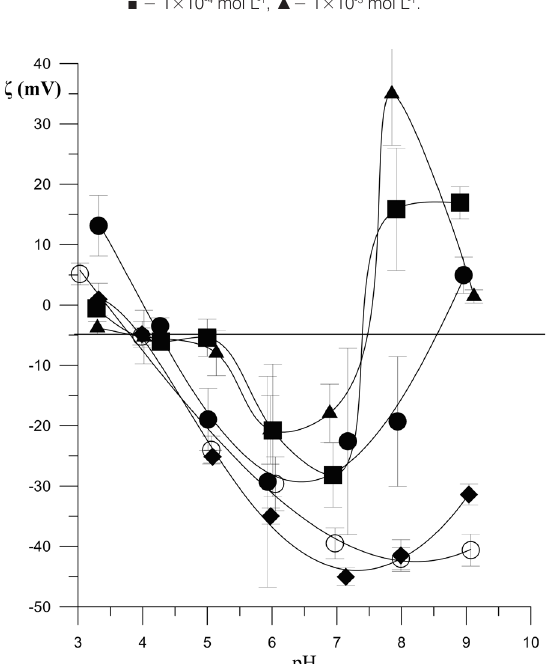
Figure 10. The potential ζ of TiO (rutile) as a function of pH in 2 the presence of Zn(II) ions. Zn (II) ions